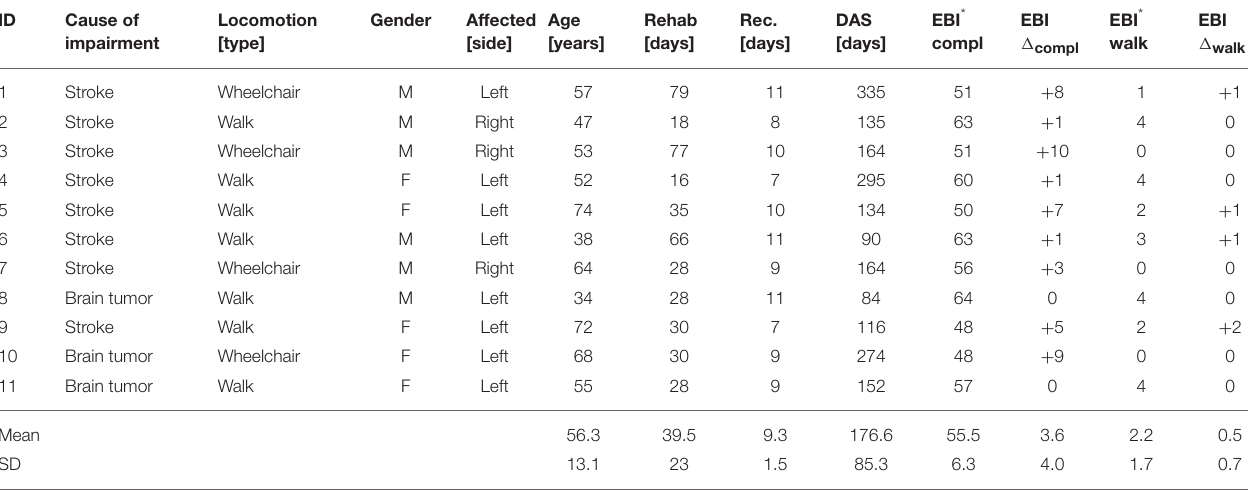
TABLE 1 | Patient